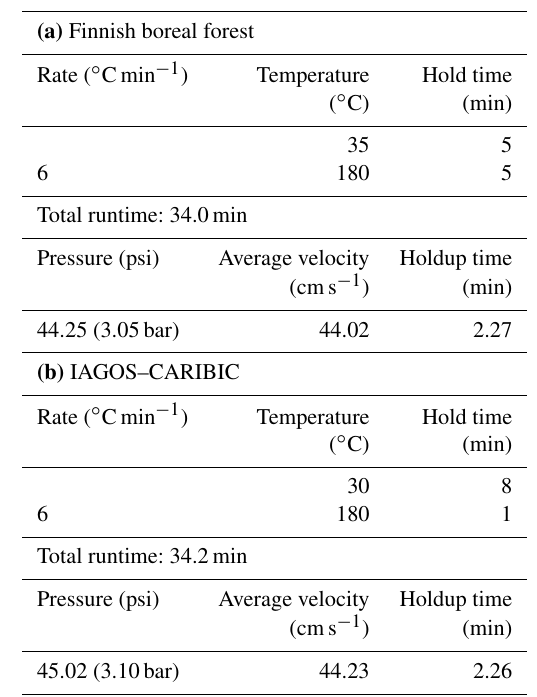
Table 3. The GC oven programs for (a) Finnish boreal forest and